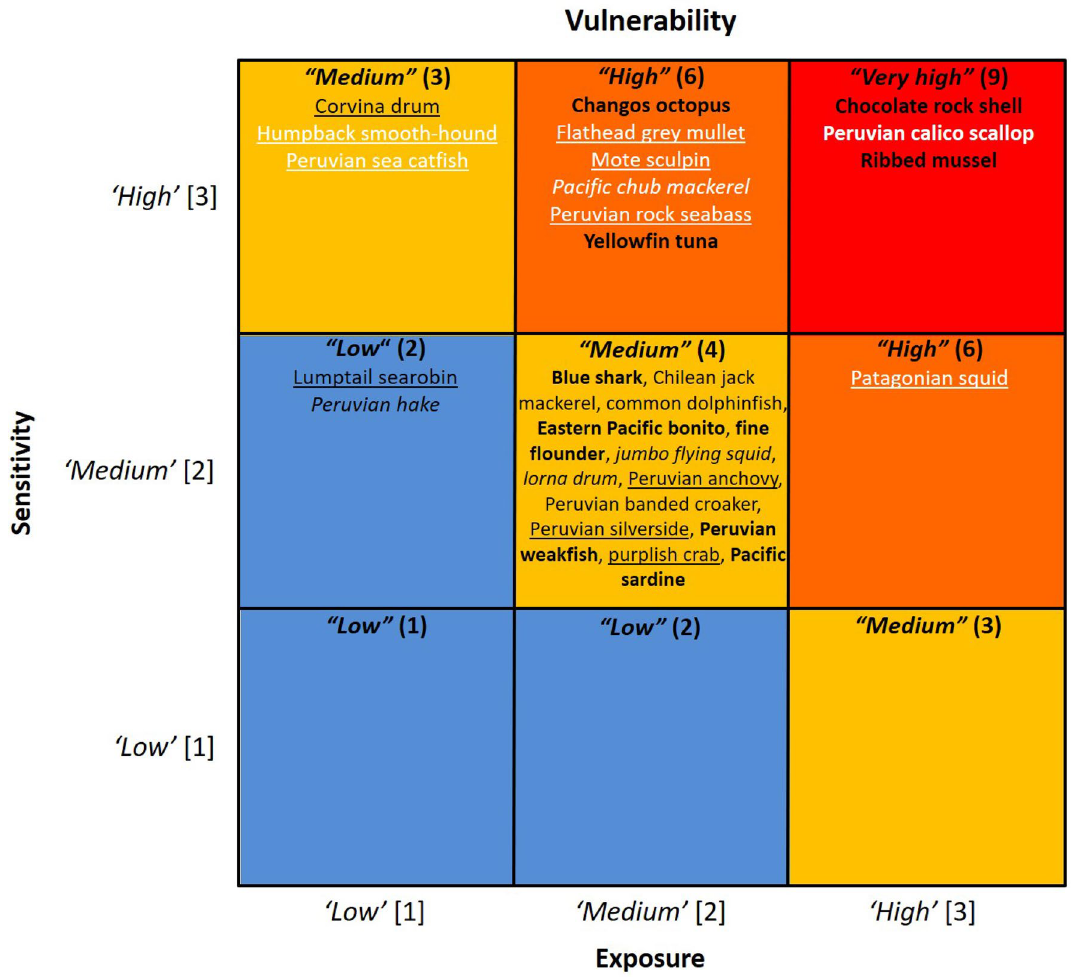
Figure 6. Vulnerability matrix, estimated from exposure to climate factors and sensitivity attributes, of key fishery resources to climate change in the Northern Humboldt Current System. Certainty from the bootstrap analysis is indicated by the style of font: > 95%) bold; 91–95%) regular; 70–90%, italic ; < 70%, underline. The vulnerability ranking of species indicated in white font changed with the leave-one-out